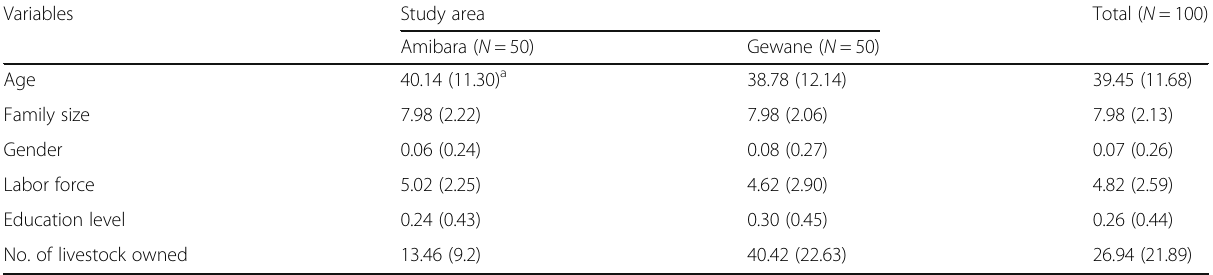
Table 3 Summary statistics of survey data, in Afar region of Ethiopia